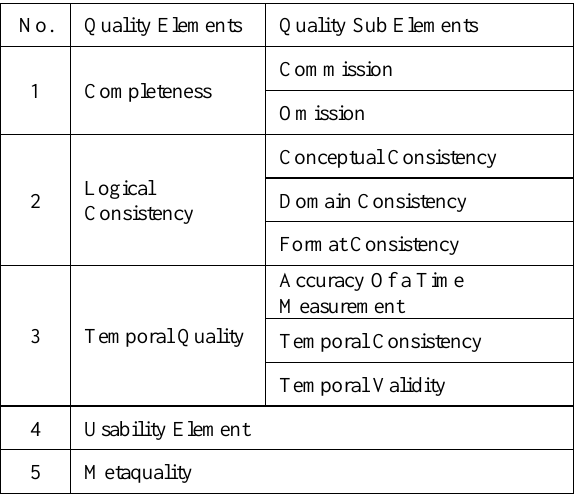
Table 2. Quality model of common